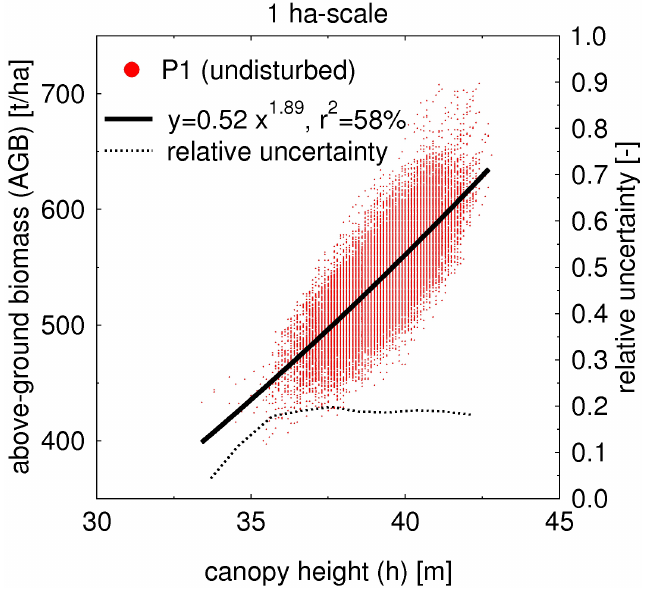
Fig. 2. Relation between above-ground life biomass (AGB) and canopy height ( h ) in 1ha-scale analysis for the undisturbed forest (site P1), including power-law regression function. Relative uncertainty (4 σ /mean) of the 95% confidence level plotted on right